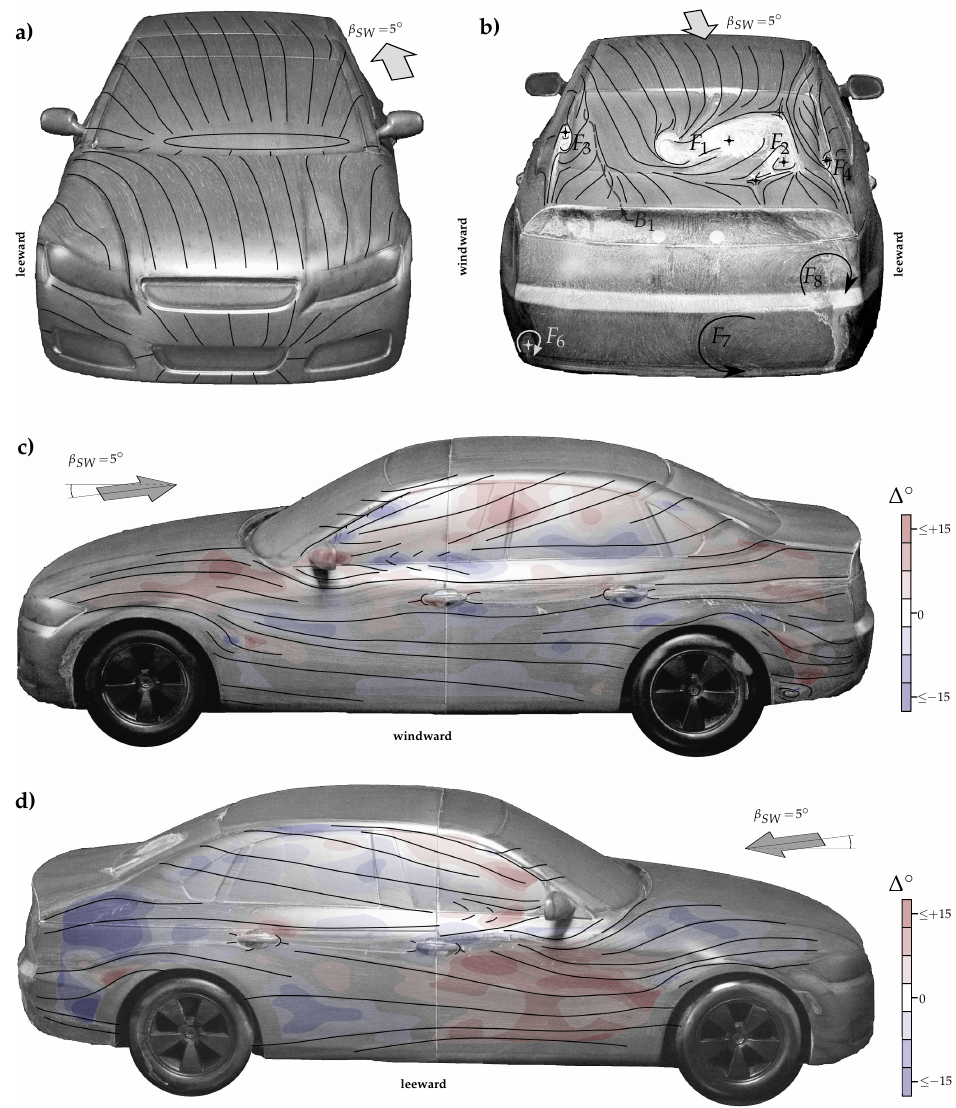
Figure 5. Surface traces at side wind condition of 5 ◦ : ( a ) front view, ( b ) rear view, ( c ) leeward side, and ( d ) windward side. The color indicates the changes in the oil trace directions in relation to the baseline case.